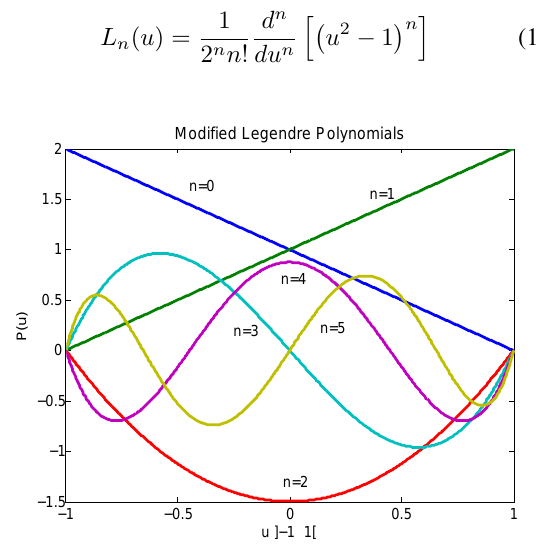
Figure 5: 5 th Order of Modified Legendre Polynomials Figure (5) shows the 5 th order modified Legendre poly- nomials introduced in one subsection. The continuity is imposed by adjusting two first order of polynomials with neighboring subsection as shown in figure (6). The higher order term ( n ≥ 2) are zeros in the extremities and do not contribute to continuity of the currents. In this article, we will study the two case: discontinuous and continuous ba- sis function. The pulse basis function are added as lowest order ( N = 0) for the discontinuous basis function. For the continuous basis, the lowest order is the triangle ( N = 1) function.